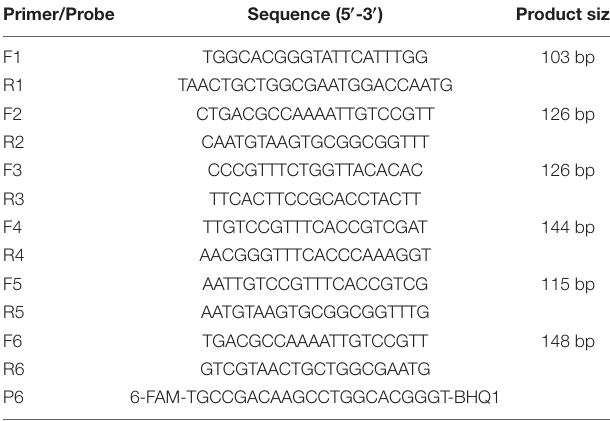
TABLE 1 | Information of bacterial strains used in this